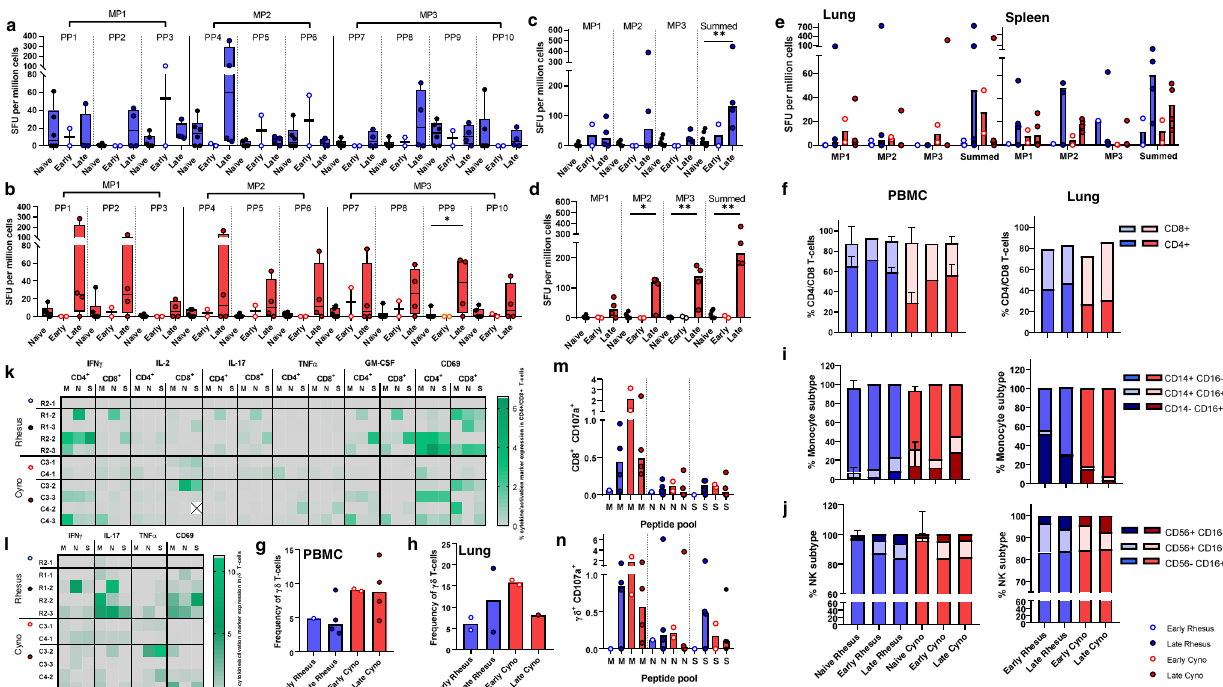
Fig. 9 Cellular immune responses to SARS-CoV-2. a , b IFN γ SFU measured in PBMCs and stimulated with spike protein peptide pools (PP) peptide in ( a ) rhesus and ( b ) cynomolgus macaques. PBMC samples were isolated from uninfected animals (naïve) or at early (days 4 and 5) and late (days 14-19) time- points following SARS-CoV-2 infection. Box plots show the group median + / − inter-quartile range, with minimum and maximum values connected by whiskers. Two-tailed Mann – Whitney U-test carried out to compare pre and post-SARS-Cov2 infection where * p ≤ 0.05, ** p ≤ 0.01. c , d IFN γ SFU measured in PBMC in response to spike protein megapools (MP) in ( c ) rhesus and ( d ) cynomolgus macaques or, ( e ) in mononuclear cells isolated from lung and spleen. Bars show the group median with SFU measured in individual animals shown as dots. Rhesus macaques summed MP naïve vs late time point p = 0.01. Cynomolgus macaques naïve vs PP9 p = 0.03, naïve vs MP2 p = 0.03, naïve vs MP3 p = 0.01, naïve vs summed p = 0.01. Biologically independent animal samples for ( a – d ); PBMCs: naïve n = 6, early n = 2, late n = 4 Biologically independent animal samples for ( e ); lung and spleen: early n = 2, late n = 4, ( f – j ) Frequency of major lymphocyte and monocyte cell populations quanti fi ed by immunophenotyping assay ( f – h ) CD4 + , CD8 + and γδ T-cell frequencies in PBMCs and lung cells, ( i ) Monocyte subtype frequency in PBMCs and lung MNCs, ( j ) Natural killer (NK) cell subset frequency in PBMCs and lung MNCs. Stacked bars show the group median with 95% con fi dence intervals. Biologically independent animal samples for ( f – j ); PBMC: Naïve rhesus n = 8, early rhesus n = 1, late rhesus n = 2, naïve cyno = 7, early cyno n = 2, late cyno n = 2. Lung: early rhesus n = 2, late rhesus n = 3, early cyno n = 2, late cyno n = 2. k – n Intracellular cytokine staining data. k – l Cytokine and activation marker detection in CD4 + , CD8 + and γδ T-cells in PBMCs stimulated with M, N and S peptide pools. m – n CD107a expression in CD8 + and γδ T-cells in PBMCs. Bars show the group median with cell frequencies measured in individual animals shown as